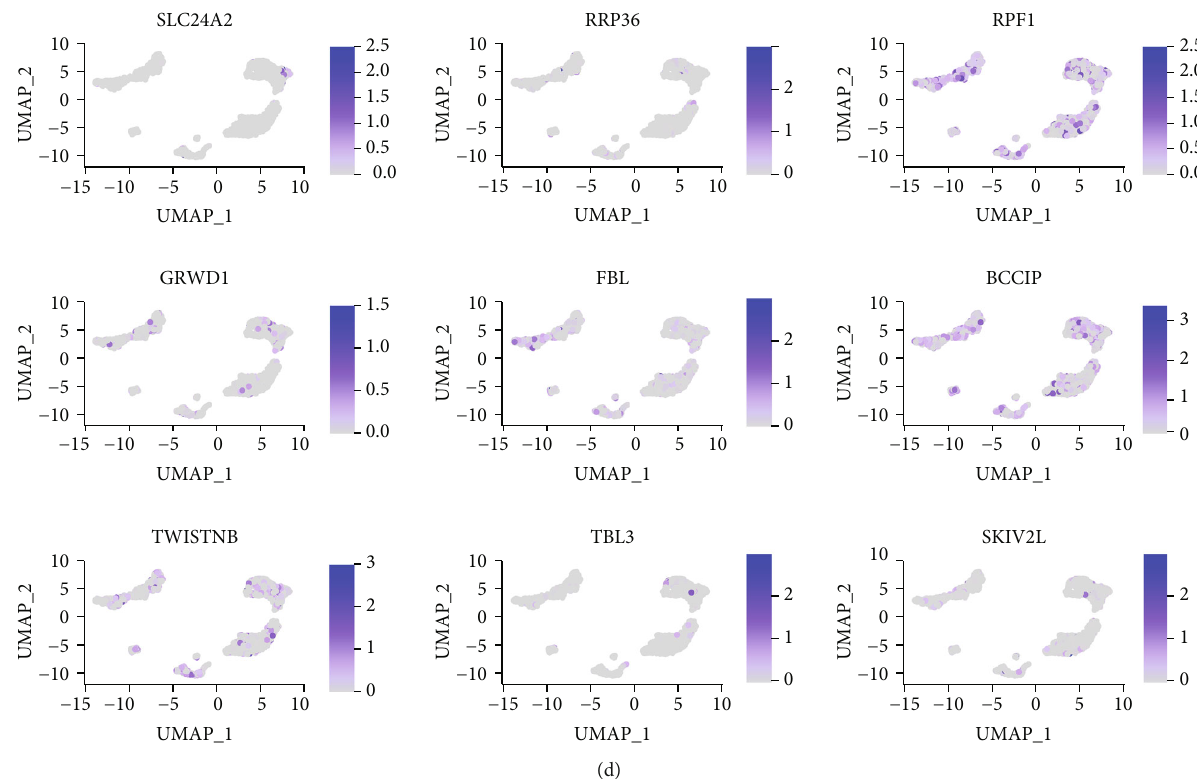
Figure 4: The SLC24A2 expression validation on scRNA-seq dataset. (a) The SLC24A2 expression between T2D and control in GSE20966. (b) The SLC24A2 expression between T2D and control in GSE25724. (c) Cell cluster annotation with UMAP dimension reduction in GSE154126. (d) Feature plot of SLC24A2 and 8 related hub gene expressions in